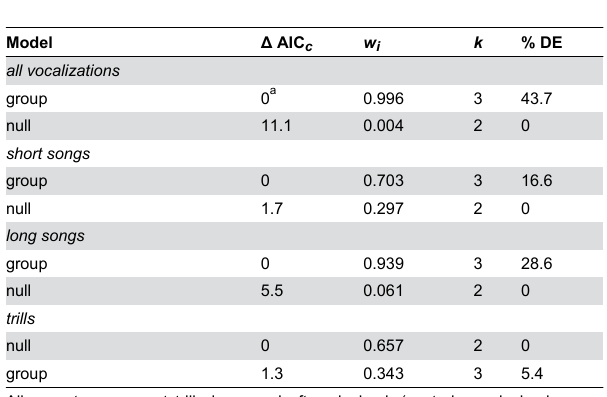
Tables 2. Evidence for playback-induced changes in the number of three individual vocalization types, non-duet vocalizations, and all vocalizations in Plain-tailed Wren Thryothorus euophrys produced in an hour period.